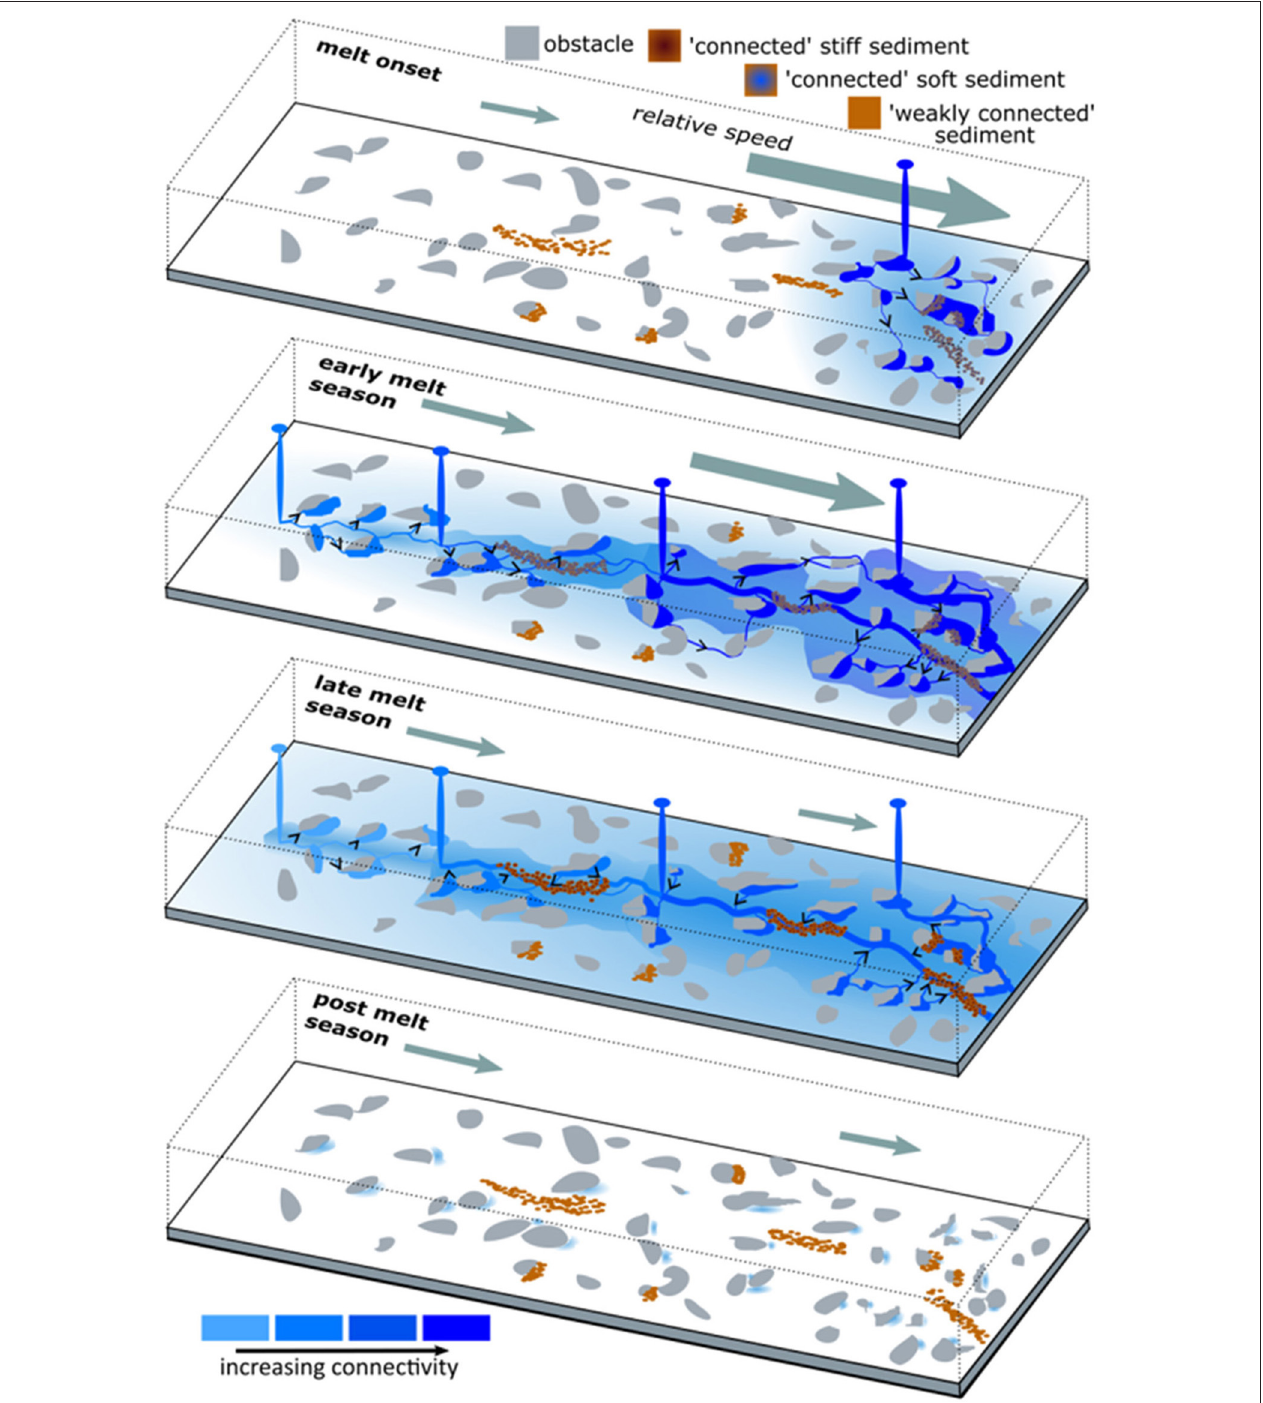
FIGURE 8 | Conceptual model of land-terminating Greenland Ice Sheet seasonal hydrology and dynamics. Melt onset activates part of the weakly-connected drainage system (white background) and subsequent fluctuations in runoff supply lead to cavity expansion, increased sediment deformation and consequent rapid speed-up (grey arrow). In the early-melt season, meltwater accesses the bed at progressively higher elevations and the efficiency and extent of the connected drainage system increases (blue shading), likely forming channels at lower elevations. Surface runoff supply frequently exceeds the capacity of the core of the connected drainage system at progressively higher elevations during the early-melt season, causing speed-up. During the late-melt season, runoff supply declines, and water drains across variable pressure axes and from the weakly-connected system toward efficient drainage forms at lower elevations, but not higher elevations, where drainage system efficiency remains low throughout the melt season. Basal water pressure and cavity size gradually increase during the post-melt season.